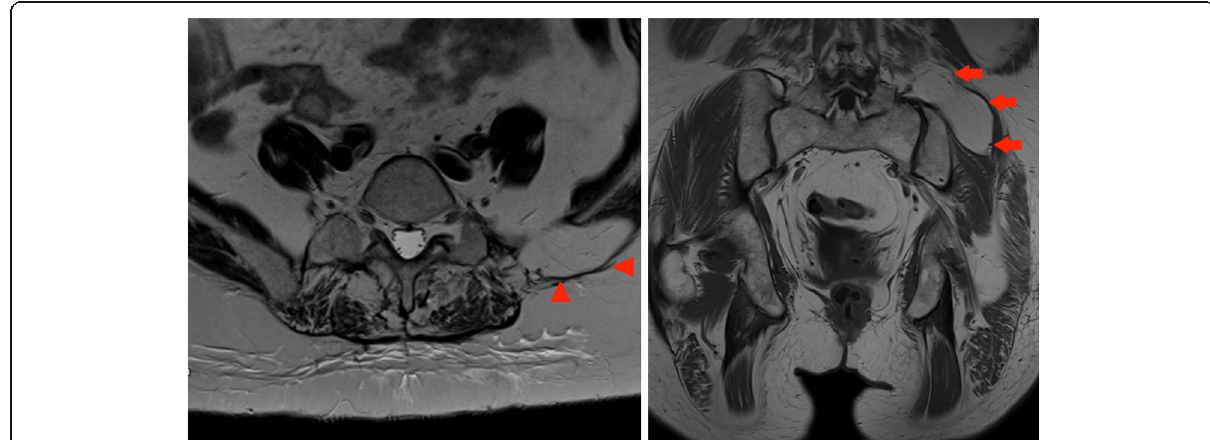
Fig. 10 Left panel: Axial T2-weighted image of the pelvis: a fatty mass is seen to extend into the lumbar soft tissues with an intramuscular component in the gluteus medius. Right panel: Coronal T1-weighted image of the pelvis: red arrows outline the lumbar defect with fatty hernia contents